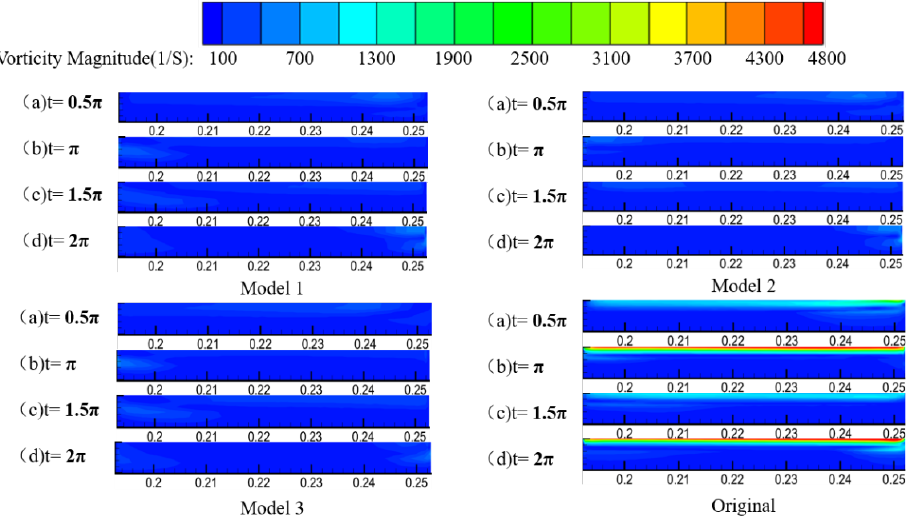
Figure 7. Pulse tube vorticity cloud.